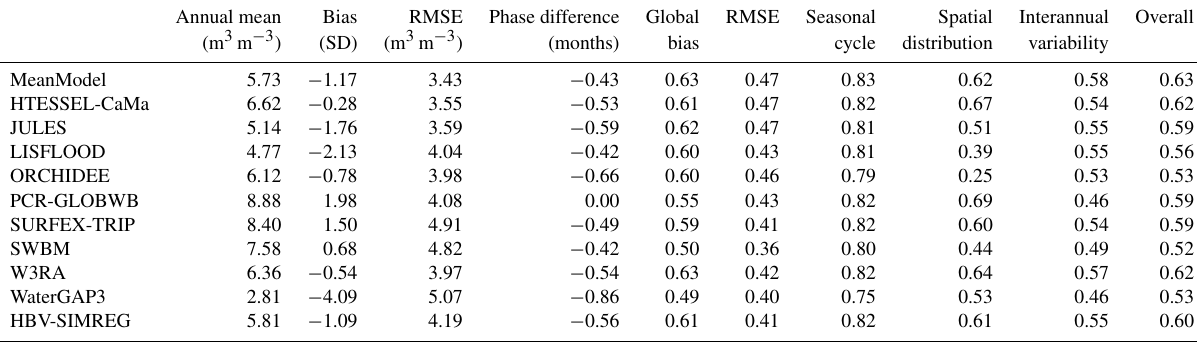
Table B6. Diagnostic summary for terrestrial water storage anomaly: model vs. GRACE. Annual mean Bias RMSE Phase difference Global RMSE Seasonal Spatial Interannual Overall (m 3 m − 3 ) (SD) (m 3 m − 3 ) (months) bias cycle distribution variability MeanModel